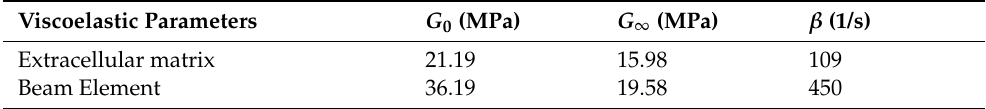
Figure 8. ( a ) The finite element model of the TM, JCT, and SC inner wall as separate layers. ( b ) The finite element model of the TM/JCT/SC complex with embedded beam elements. Table 2. Viscoelastic parameters for the TM patch FE model. The ECM and beam elements were modeled as the viscoelastic material. The β was fixed in this cycle of optimization and the time- dependent shear moduli were